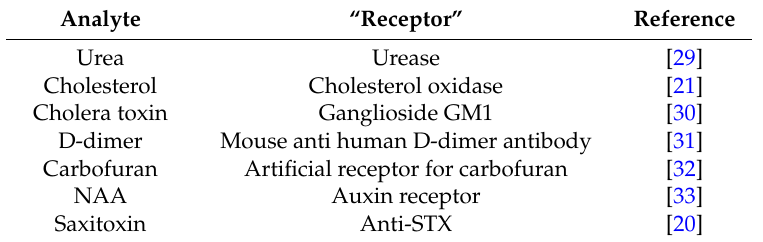
Table 1. Examples of lipid modified graphene-based biosensors for the detection of various